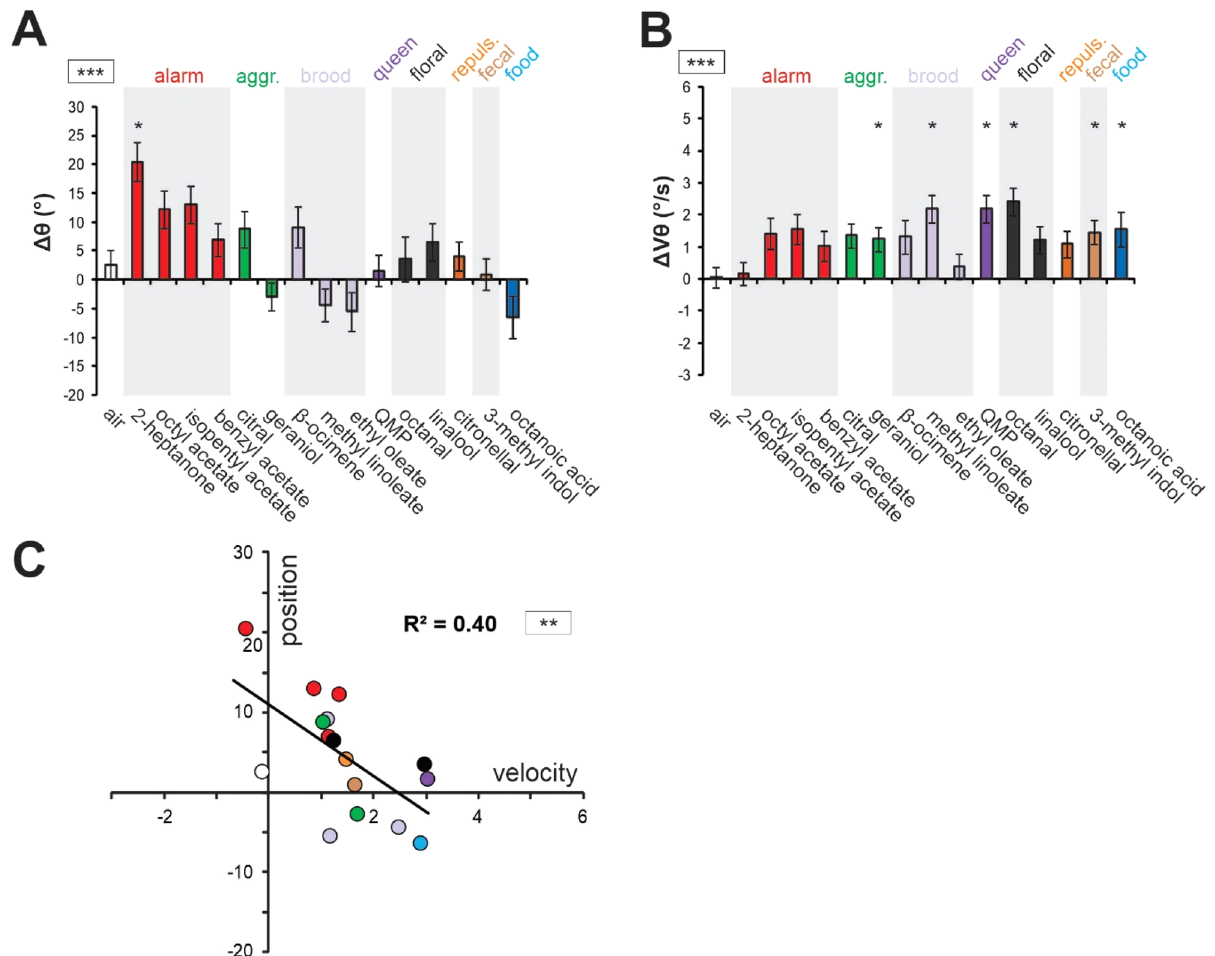
Figure 3. Relationship between changes in antennal angular position (Δθ) and velocity (ΔVθ) in response to odorants. ( A,B ) Histograms showing the change in antennal movements in response to odor presentation (during–before odor) in terms of ( A ) angular position (Δθ) and ( B ) angular velocity (ΔVθ) when pooling data from both experimental years (N = 49). Asterisks in the square next to the graph indicate significant a significant heterogeneity in antennal movements between odorants (RM-ANOVA, ***: p < 0.001). Asterisks on the histograms indicate significant differences in Dunnett post-hoc tests comparing each value to the air control (*: p < 0.05). ( C ) Regressions comparing bees’ responses to the stimuli in terms of antennal angular position (Δθ) and velocity (ΔVθ). Asterisks in the square next to the graph indicate significance in a Pearson correlation test (**: p <